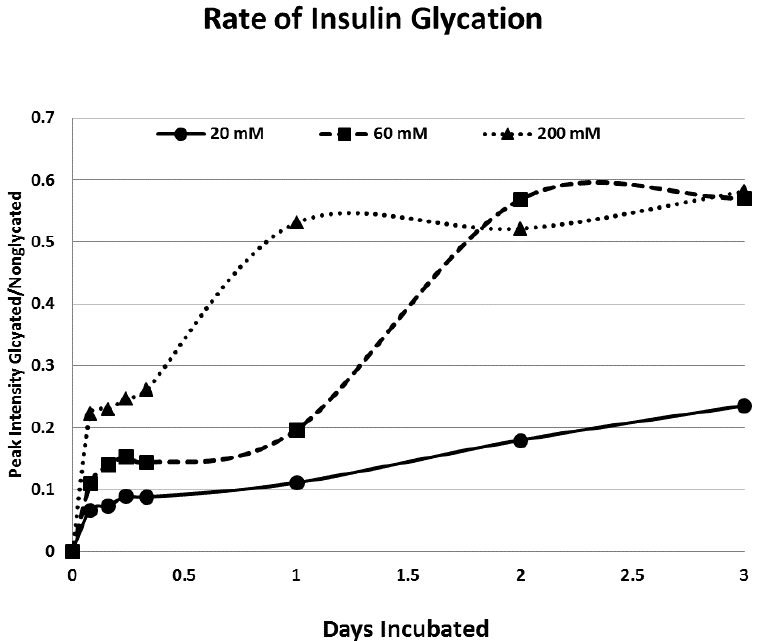
Figure 4. Rate of insulin glycation at various concentrations of glucose as determined by MALDI-TOF. Note that the glycation is a two-step process with a very rapid glycation occurring during the first hours of exposure to glucose and a slower glycation process occurring over several days. Data is plotted as a running average of multiple measurements at each time point.